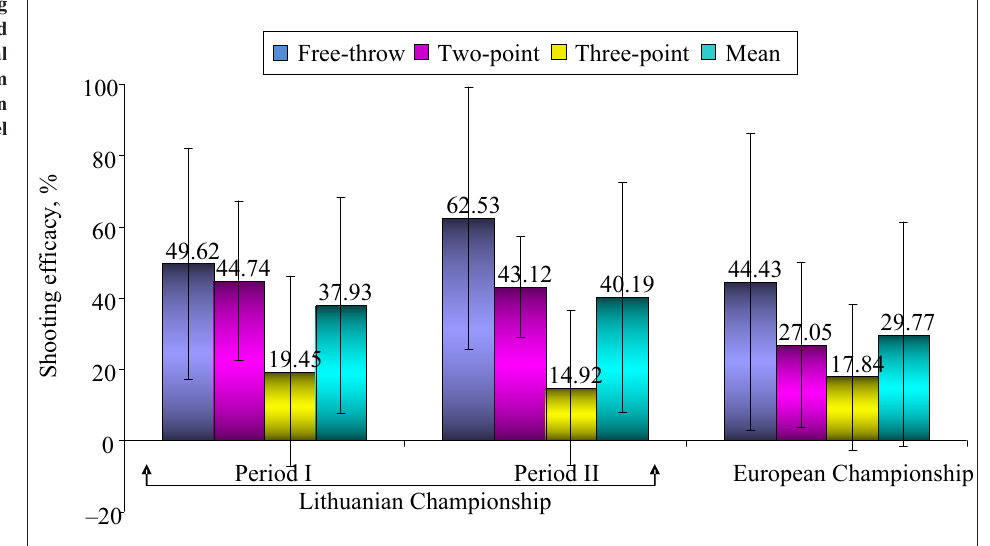
Figure 1. Shooting efficacy of LBC and Lithuanian national youth female team depending on competition level ( X ± s )